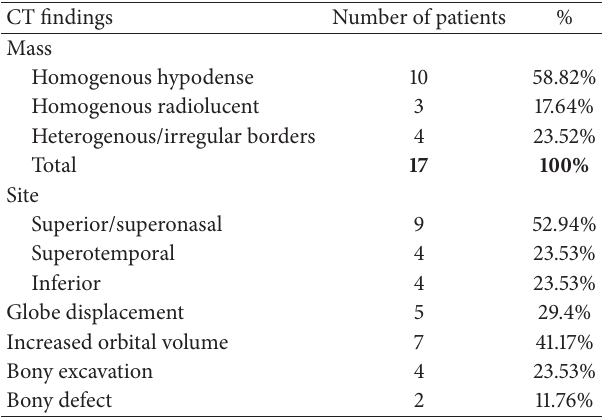
Table 2: Frequency of various orbital findings in CT scans. Hypo- dense appears grayish while radiolucent appears